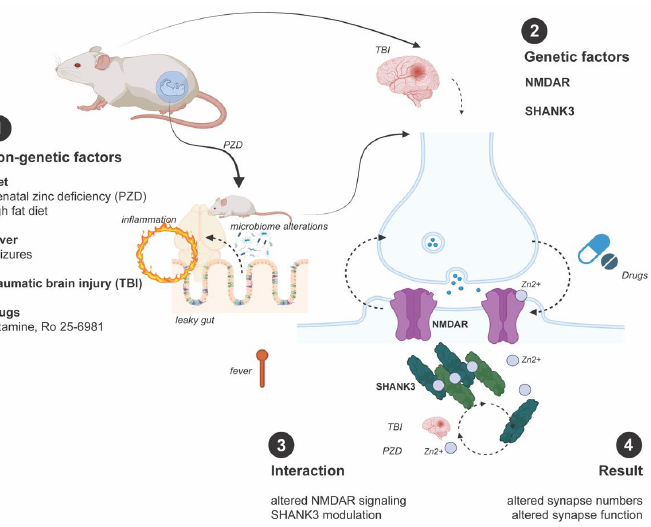
Figure 1. Some of the many possible interactions between non-genetic factors and the synapses discussed in articles in this Special Issue, affecting synapse formation and plasticity. Altered synaptic functions will ultimately cause, contribute to, or modify the physiology or pathology of the CNS.